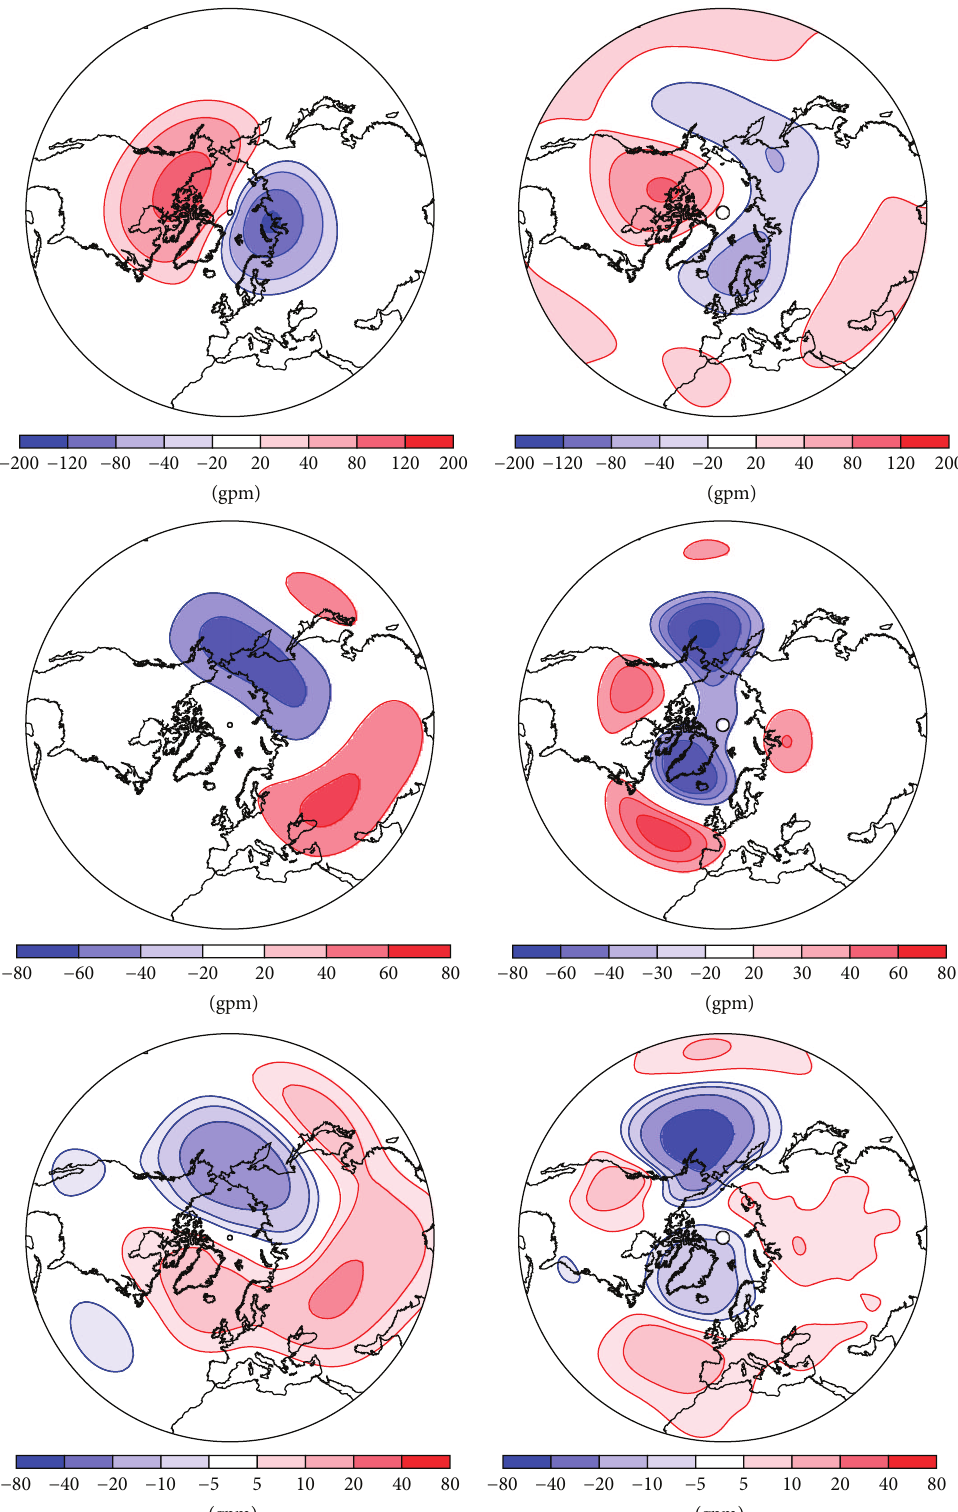
Figure 8: (Left) second EOF of geopotential height (gpm) of the (top) 167 hPa, (middle) 500 hPa, and (bottom) 833 hPa model level. (Right) same as left column, but for the layer-averaged NCEP-NCAR reanalysis